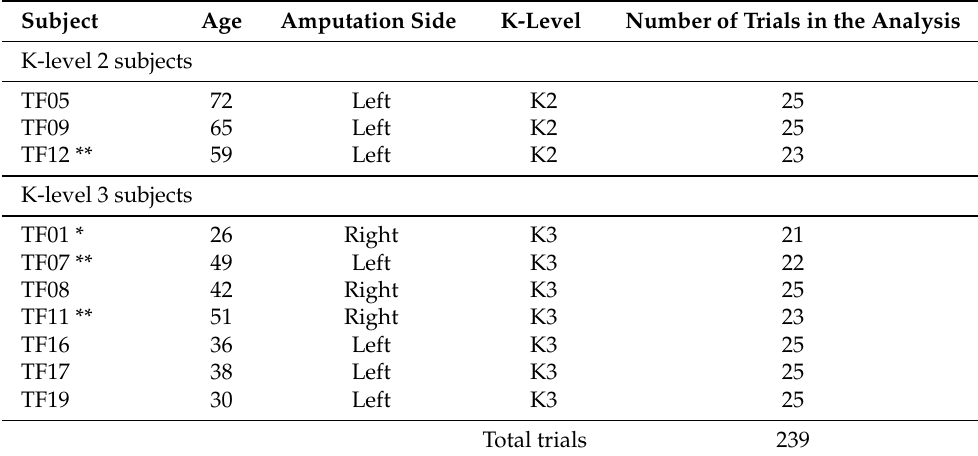
Table 1. List of subjects for whom the walking data is used in this study. Complete details on amputation can be found in